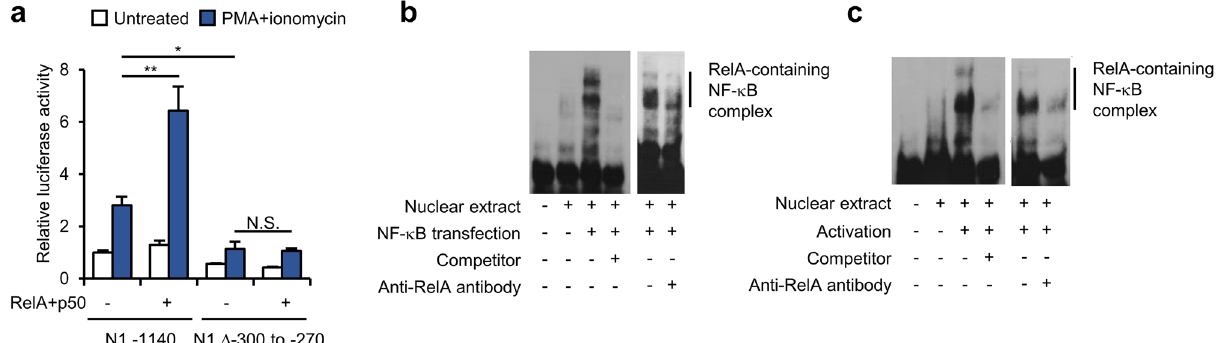
Figure 3. Validation of the predicted binding proteins for the Notch1 − 300 to − 270 sequence. ( a ) Luciferase reporter assay performed in activated Jurkat T cells that were overexpressing RelA or p50. ( b, c ) An electrophoretic mobility shift assay was performed using a Notch1 − 300 to − 270 sequence probe, and the probe- NF-κB complex was disrupted by an anti-RelA antibody in ( b ) RelA- and p50-overexpressing HEK293T cells, and ( c ) in activated Jurkat T cells. The original blots are presented in Supplementary Fig. 2. Data are presented as the mean ± SD. * P ≤ 0.05, ** P ≤ 0.01, and *** P ≤ 0.001 (Student’s t -test). N.S., not